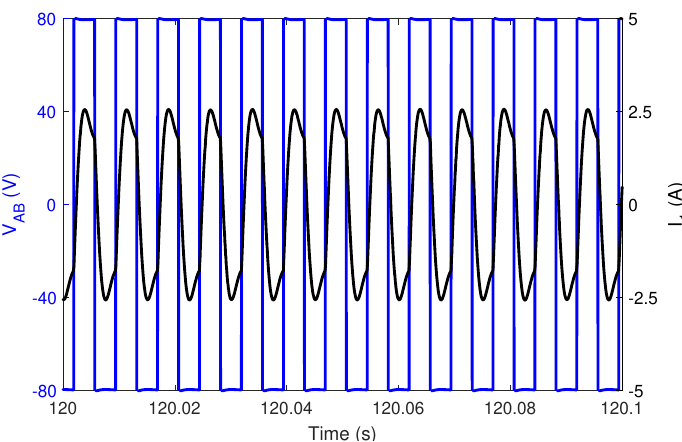
Figure 14. Inverter output voltage and